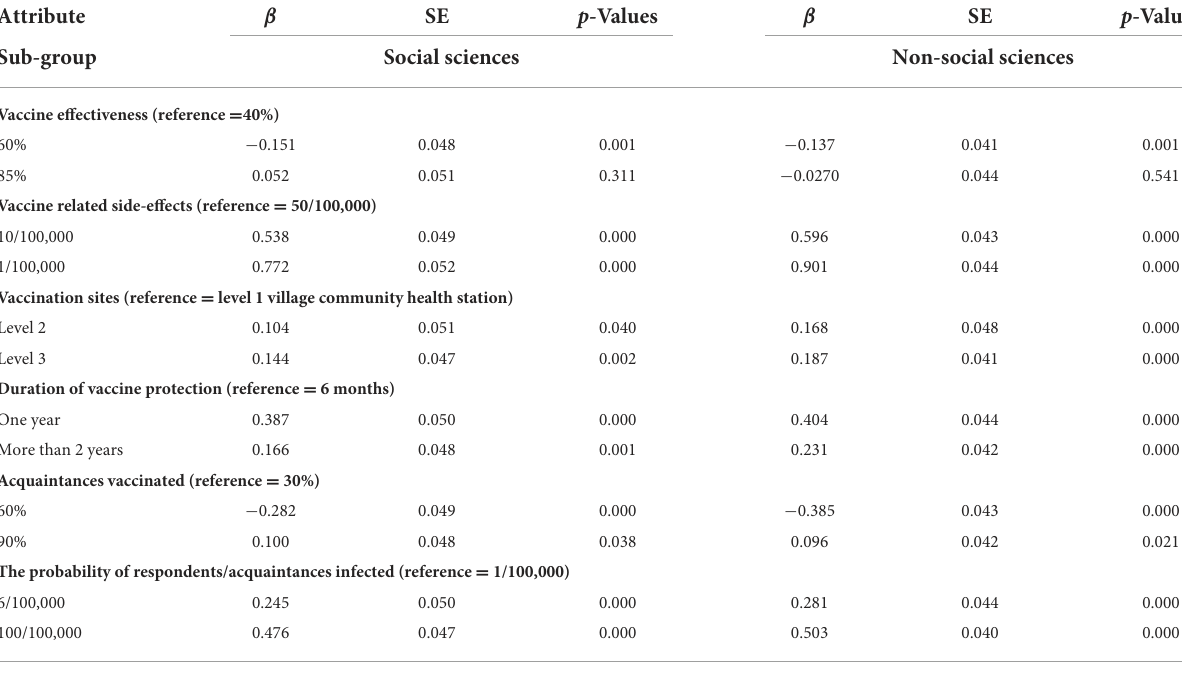
TABLE 6 Sub-group analysis for student majors.